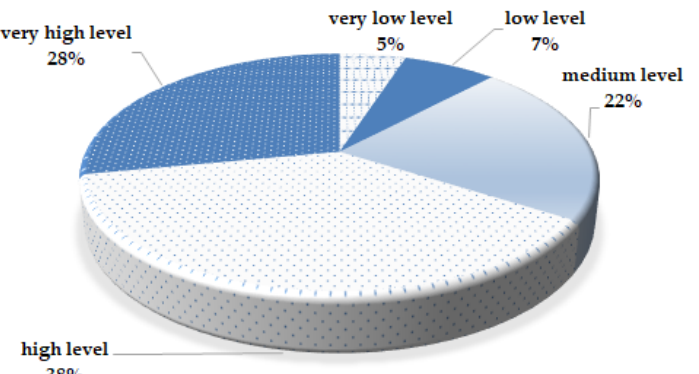
Figure 8. Emotional involvement of respondents in creating personalized products. Source: own study.